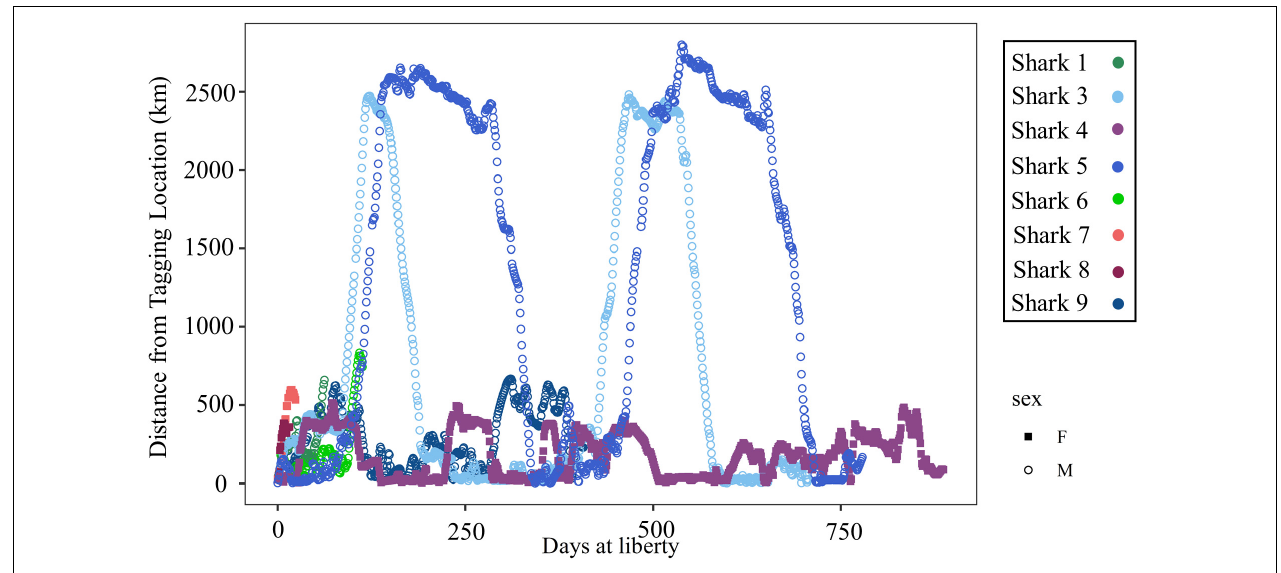
FIGURE 6 | Distance (km) of daily locations from the tagging location plotted by days at liberty since the tagging date for 8 shortfin makos tagged in the northwestern Gulf of Mexico. Females are represented by closed squares and males by open circles. Individual sharks are represented by unique colors.